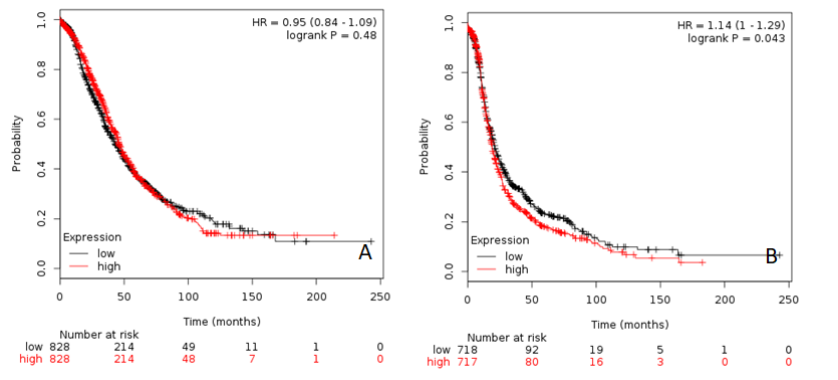
Figure 4: Overall survival (OS) and progression-free survival (PFS) curve of ovarian cancer (A: OS of ovarian cancer; B: PFS of ovarian